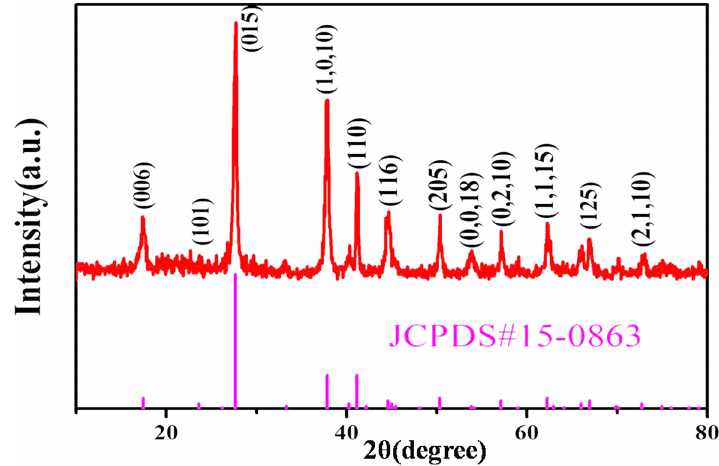
Figure 1. XRD pattern of as-prepared Bi 2 Te 3 nanostructures.